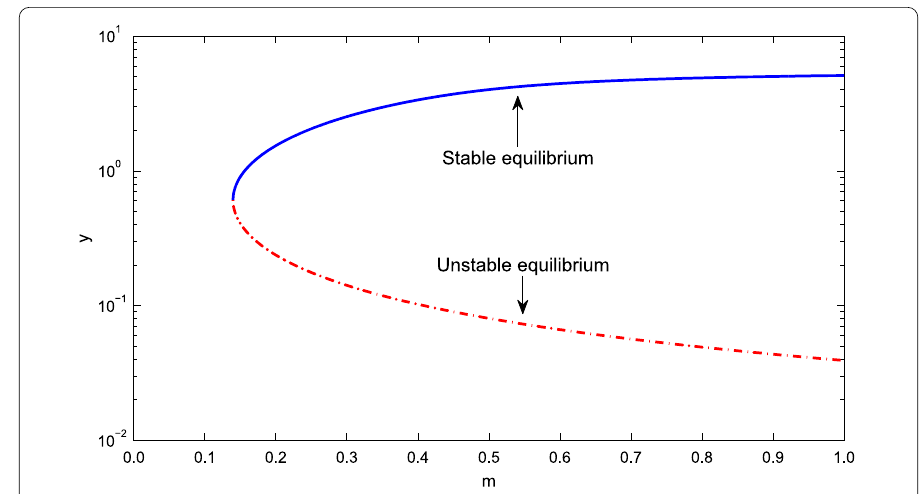
Figure 8 Bifurcation diagram in the plane ( m , ¯ y ) for parameter values λ = 0.1, μ = 0.1, β = 0.5, γ = 0.1, h = 60, p = 3, and L = 100. The diagram shows that two endemic equilibria do exist for high enough values of m . The dashed-dotted curve corresponds to the unstable endemic equilibrium, while the solid one corresponds to the stable endemic equilibrium